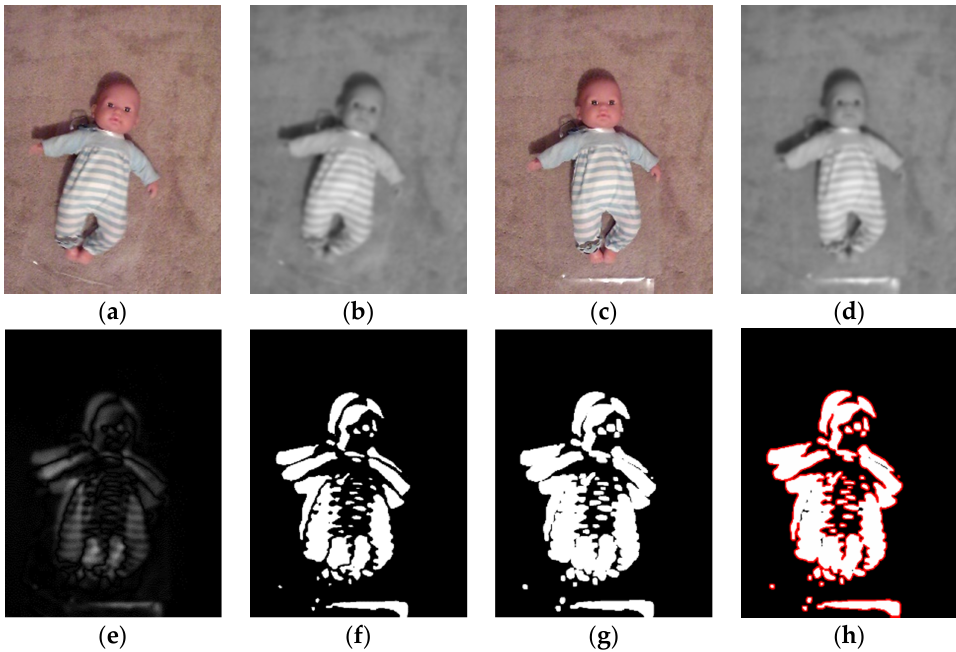
Figure 11. (a) the previous frame; ( b ) previous frame grayscaled and blurred; ( c ) the current frame; ( d ) current frame grayscaled and blurred; ( e ) absolute difference image between ( b ) and ( d ); ( f ) black and white binary image using thresholding; ( g ) image after dilation; ( h ) contours shown in red.